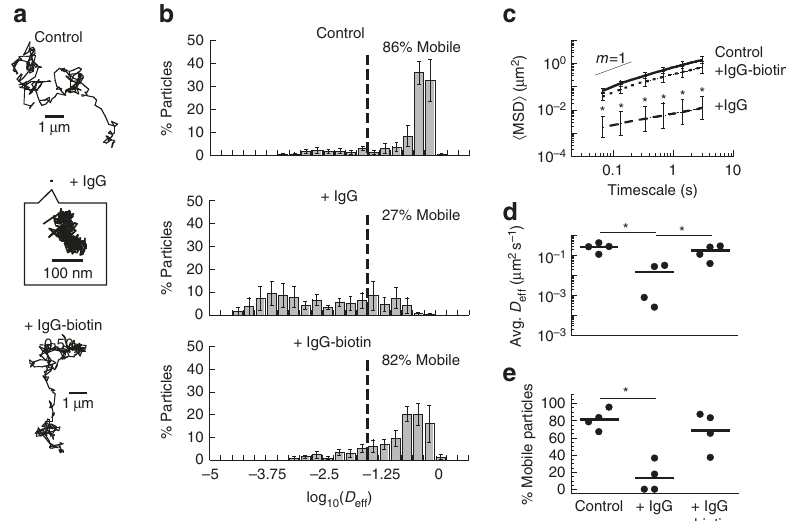
Fig. 1 Transient vs. stable anchor-matrix bonds. Diffusion of 200 nm polyethylene glycol (PEG)-conjugated latex nanoparticles in biotinylated Matrigel® modi fi ed with neutravidin. a Representative traces of nanoparticles in Matrigel® with no added IgG (control), anti-PEG IgG (IgG), or biotinylated anti-PEG IgG (IgG-biotin) exhibiting effective diffusivities within one SEM of the ensemble average at a timescale of 1 s. b Distributions of the mean logarithms of individual particle effective diffusivities ( D eff ) at a timescale of 0.2667 s. Log ( D eff ) values to the left of the dashed line correspond to particles with displacements of less than 100 nm (i.e., roughly the particle diameter) within 0.2667 s. c Ensemble-averaged geometric mean square displacements ( < MSD > ) as a function of timescale, d mean D eff of all particles in each condition, and e fraction of mobile nanoparticles in Matrigel® treated with different IgG. N = 4 separately prepared slides/condition with 83 – 237 particles tracked per slide. Error bars represent SEM. * p < 0.05 compared to control in indicated comparisons. p values were calculated by repeated measures two-way ANOVA in c , with one-way ANOVA on